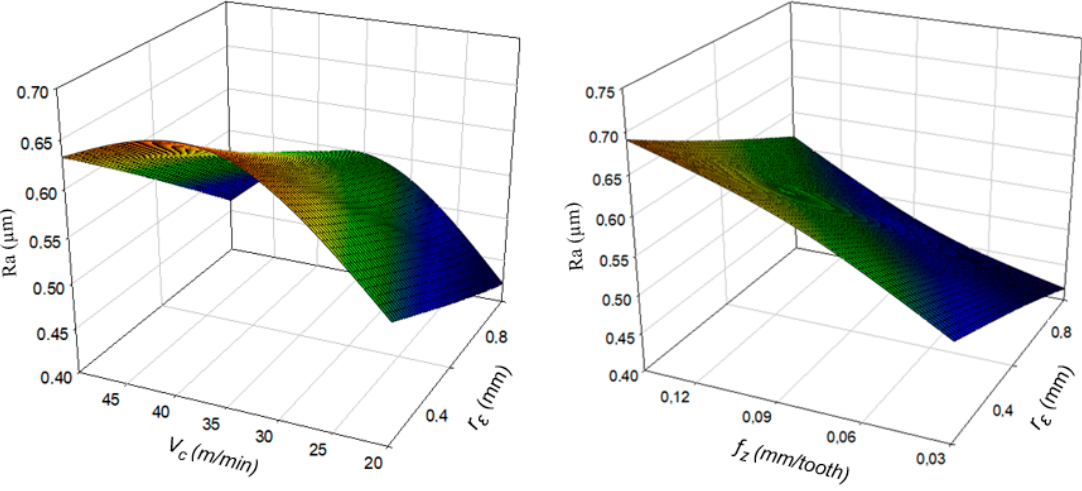
Figure 8. Effect of the cutting parameters on Ra.